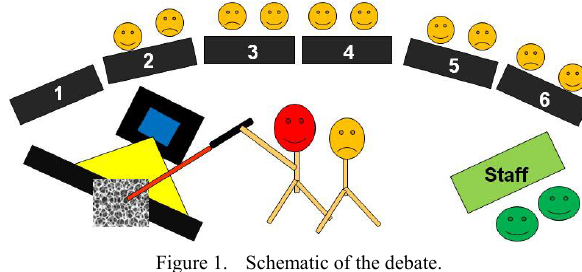
Figure 1. Schematic of the